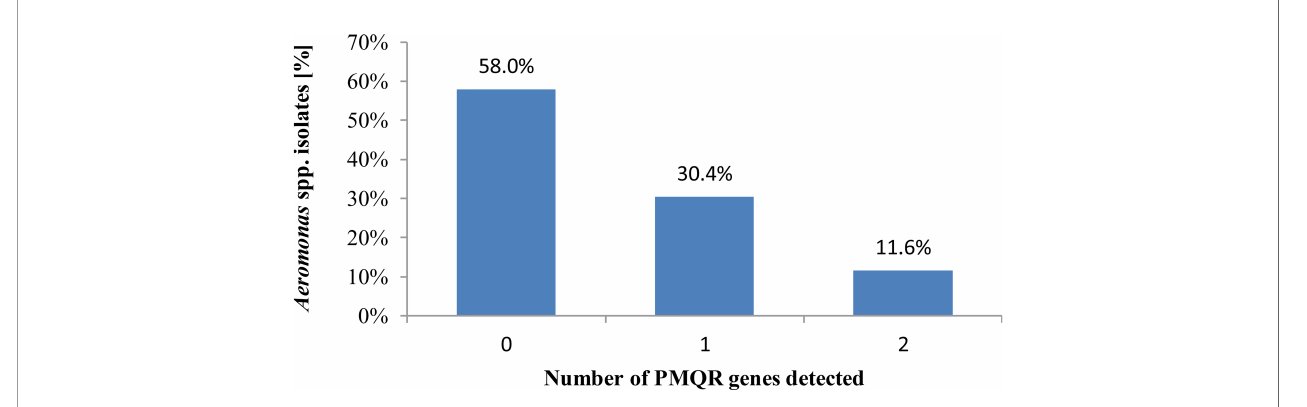
FIGURE 3 | Number of plasmid-mediated fl uoroquinolone resistance determinants possessed by Aeromonas spp. freshwater-borne isolates.